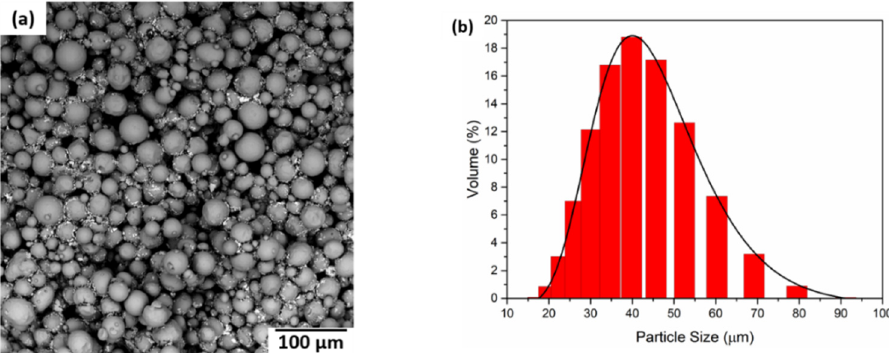
Figure 1. SEM micrograph of the Ti6Al7Nb powder particles ( a ); and ( b ) powder particle size distribution of the Ti6Al7Nb particles.